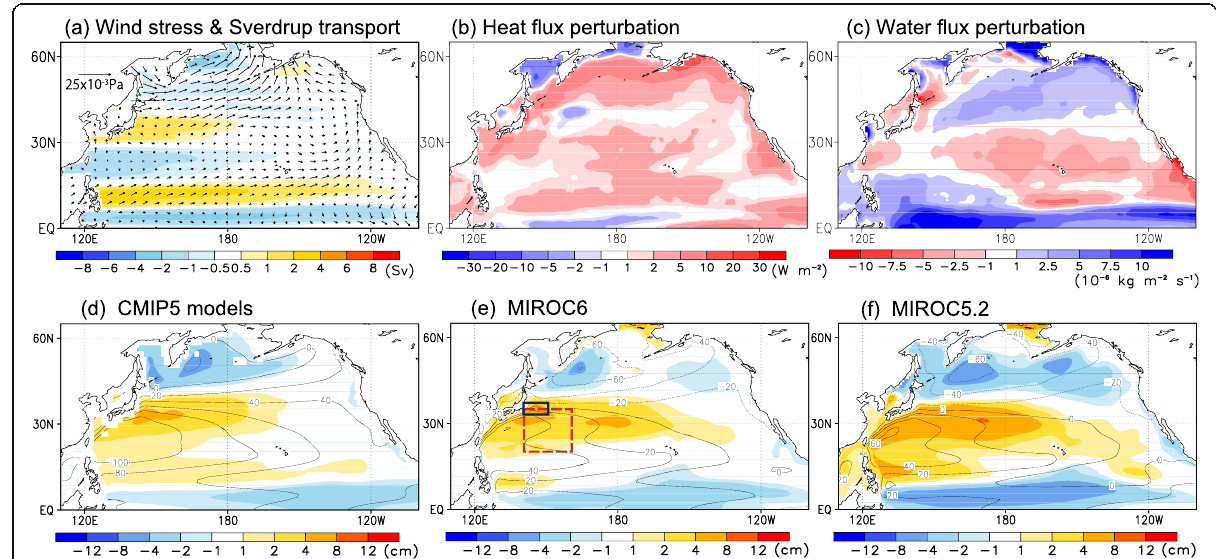
Fig. 1 Imposed surface flux perturbations in the North Pacific for a wind stress (arrows), b downward heat flux, and c downward water flux. These values are anomalies computed from the time mean of years 61 – 80 in the 1pct CO 2 experiment relative to climatology in piControl. In a , colors indicate the stream function of the Sverdrup transport. The lower panels show the dynamic sea level changes of d the CMIP5 multi-model ensemble, e MIROC6, and f MIROC5.2. Time-averages are taken in years 61 – 80 of the 1pct CO 2 experiments for CMIP5-MME and in years 51 – 90 for MIROC6 and MIROC5.2. Note that the basin average in the North Pacific is subtracted from the dynamic sea level change at each grid. Contours indicate piControl climatology. Dashed red and solid blue rectangles in e indicate the Kuroshio Extension recirculation (20° N – 35°